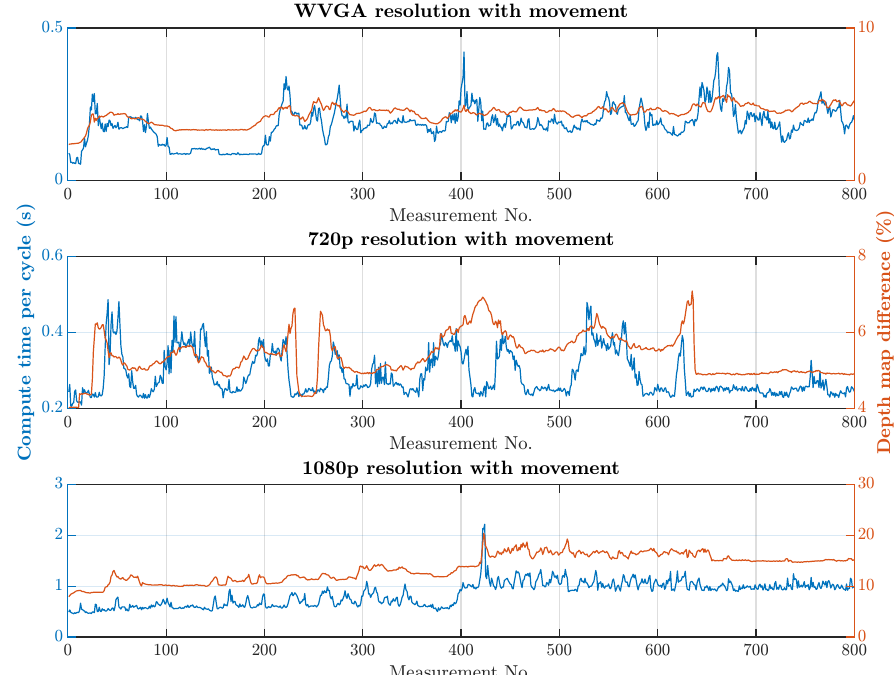
Figure 14. Results without HOG and with